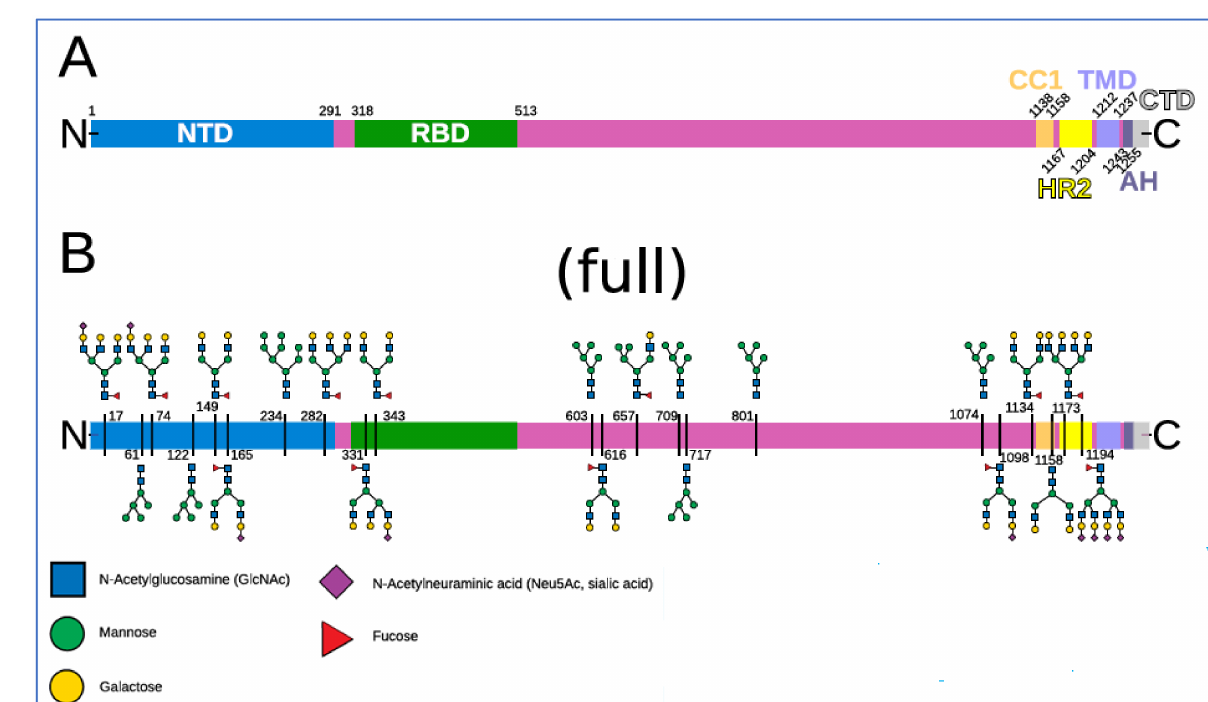
Figure 4. Spike domains and glycosylation. Reproduced from Sikora et al., 2021 [140] (CC-BY 4.0). ( A ) Domains of S (SARS-CoV-2 spike protein). ( B ) Glycosylation pattern of S. Sequons are indicated with the respective glycans in a schematic representation for a fully glycosylated system (“full”). A key to the monosaccharides represented is shown at the